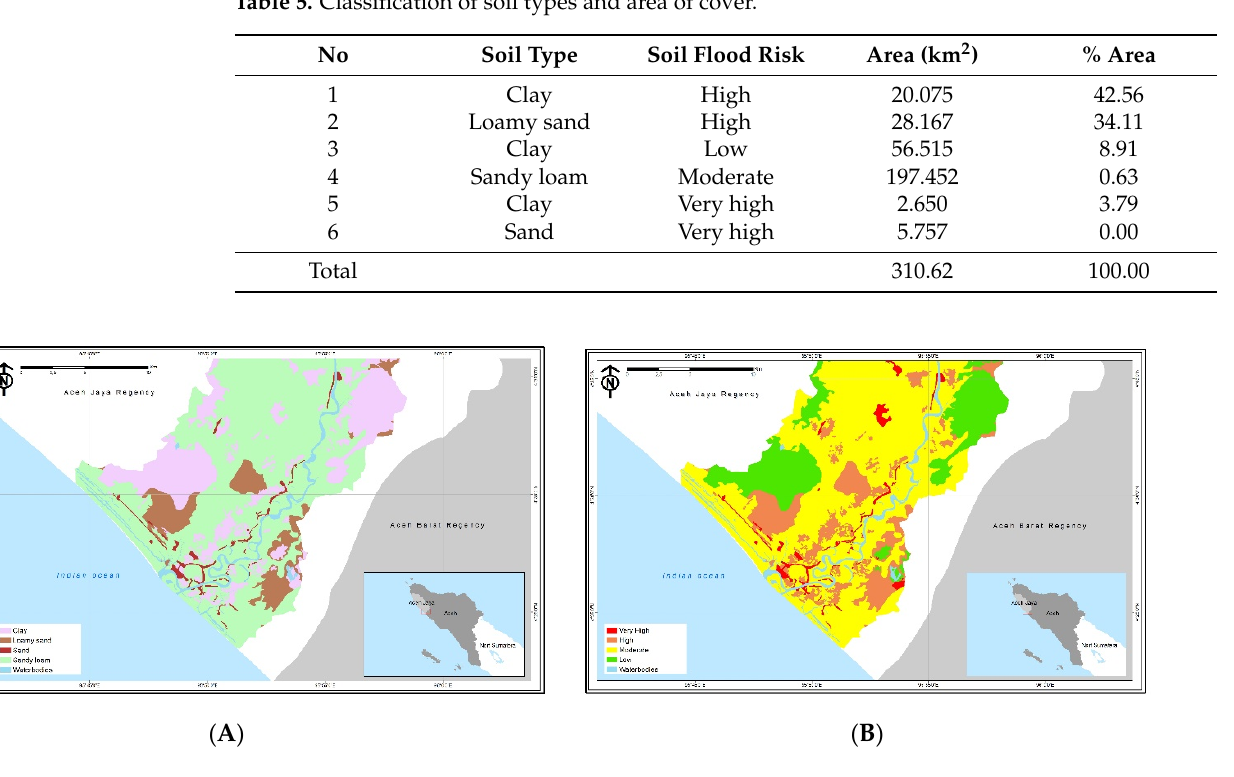
Table 5. Classification of soil types and area of cover.